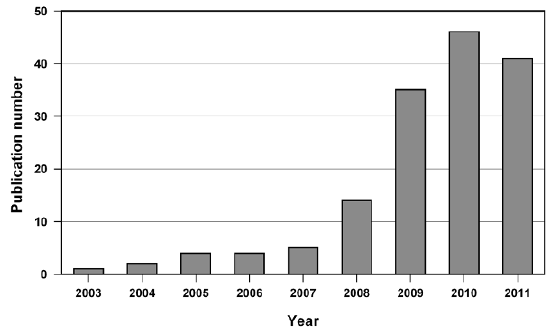
Figure 1. Number of articles published worldwide per year (from 2003 to August 2011) on the subject “ionic liquids and